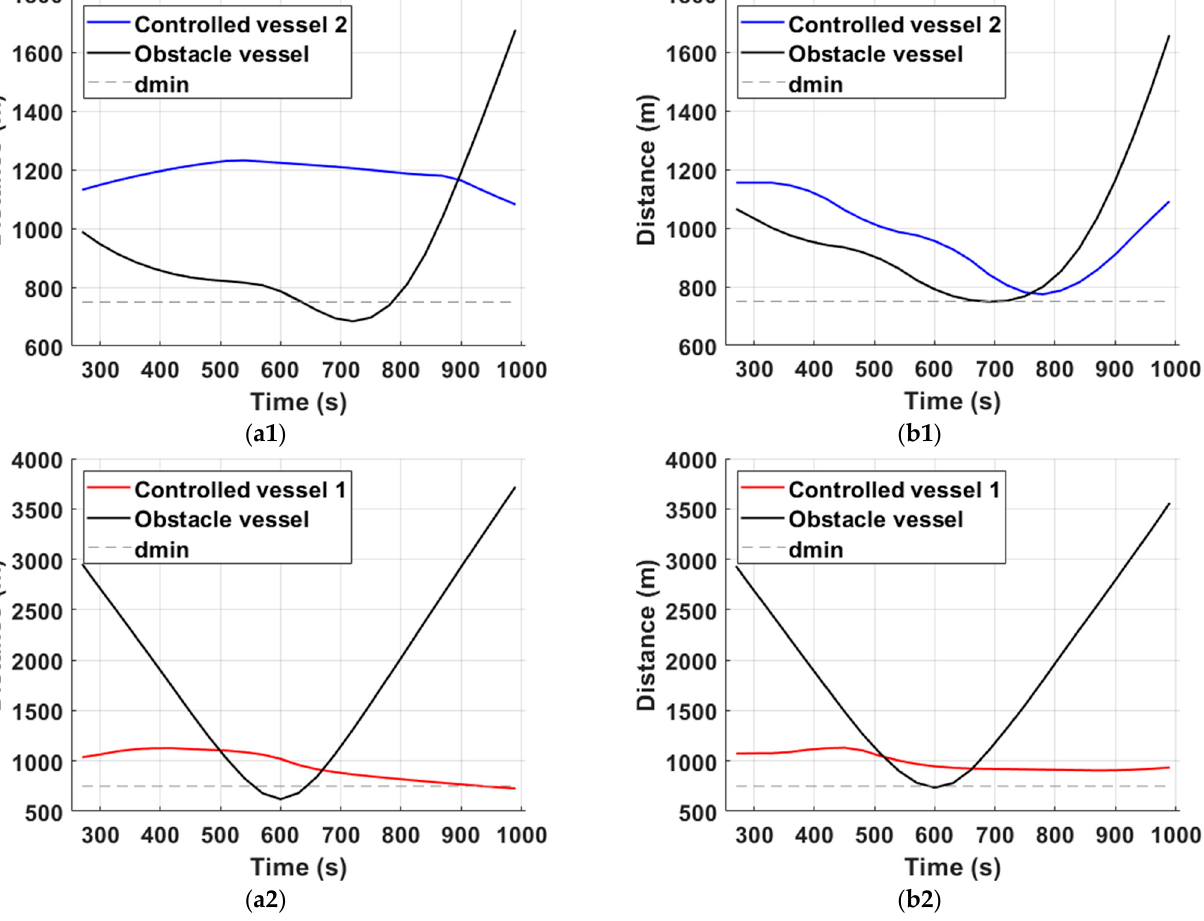
Figure 9. Distance plots for scenarios 1 & 2. The left subfigure column refers to the MPC-SLP scheme, while the second to the MPC-RBFP scheme. Note that for scenario 1 ( a1, b1 ) and for scenario 2 ( a2, b2 ), the MPC-SLP violates the lower limit on distance from CPA; therefore, its trajectories are deemed unsafe. Table 4. Performance metrics for the generated trajectories of the MPC-RBFP and MPC-SLP schemes for the two simulation scenarios.